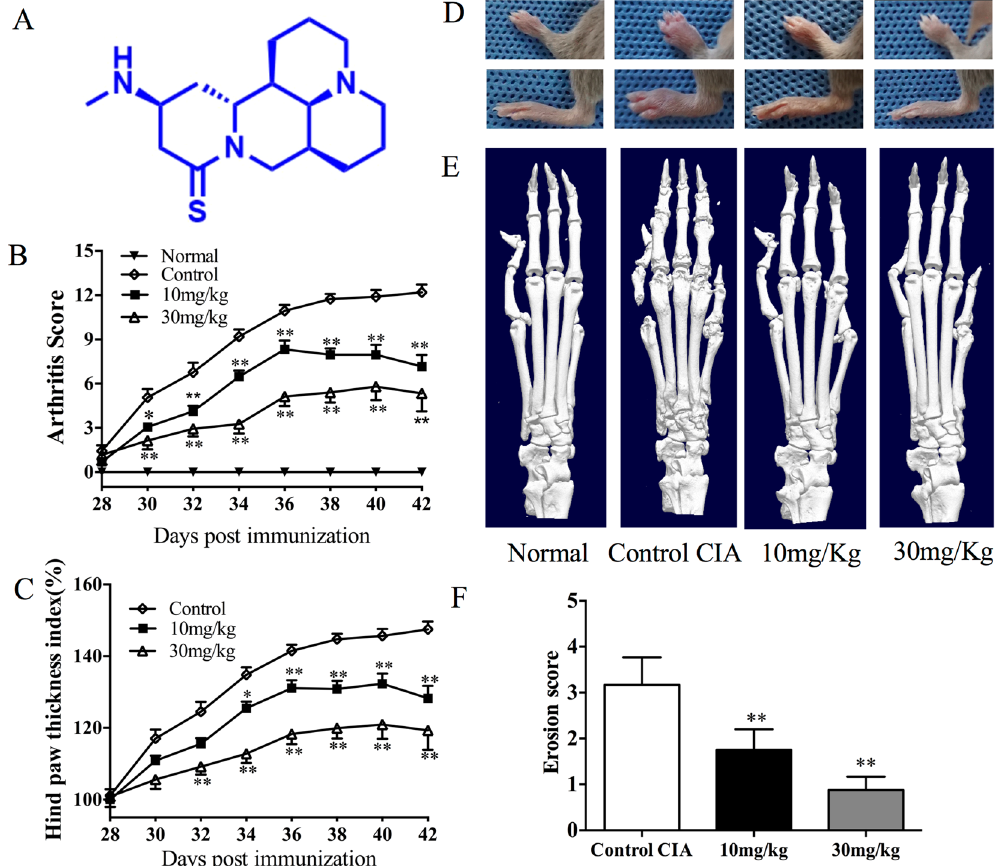
Figure 1. Effects of MASM administration on mice with CIA. Mice were injected with saline or the indicated concentrations of MASM on day 22 (1 day after booster immunization on day 21). ( A ) The chemical structure of MASM. The mean clinical arthritis scores ( B ) and the hind paw thicknesses ( C ) were determined on the indicated days after the primary immunization. ( D ) Representative photographs of the hind paws of CIA mice on day 42. ( E ) Representative photographs of 3D reconstruction of micro-computed tomography of the hind paws (right) of mice with CIA. ( F ) Bone Erosion scores in CIA groups. Values in ( B ), ( C ), ( F ) are mean ± SEM from a representative experiment (n = 10~15). * P < 0.05, ** P < 0.01 versus CIA mice treated with